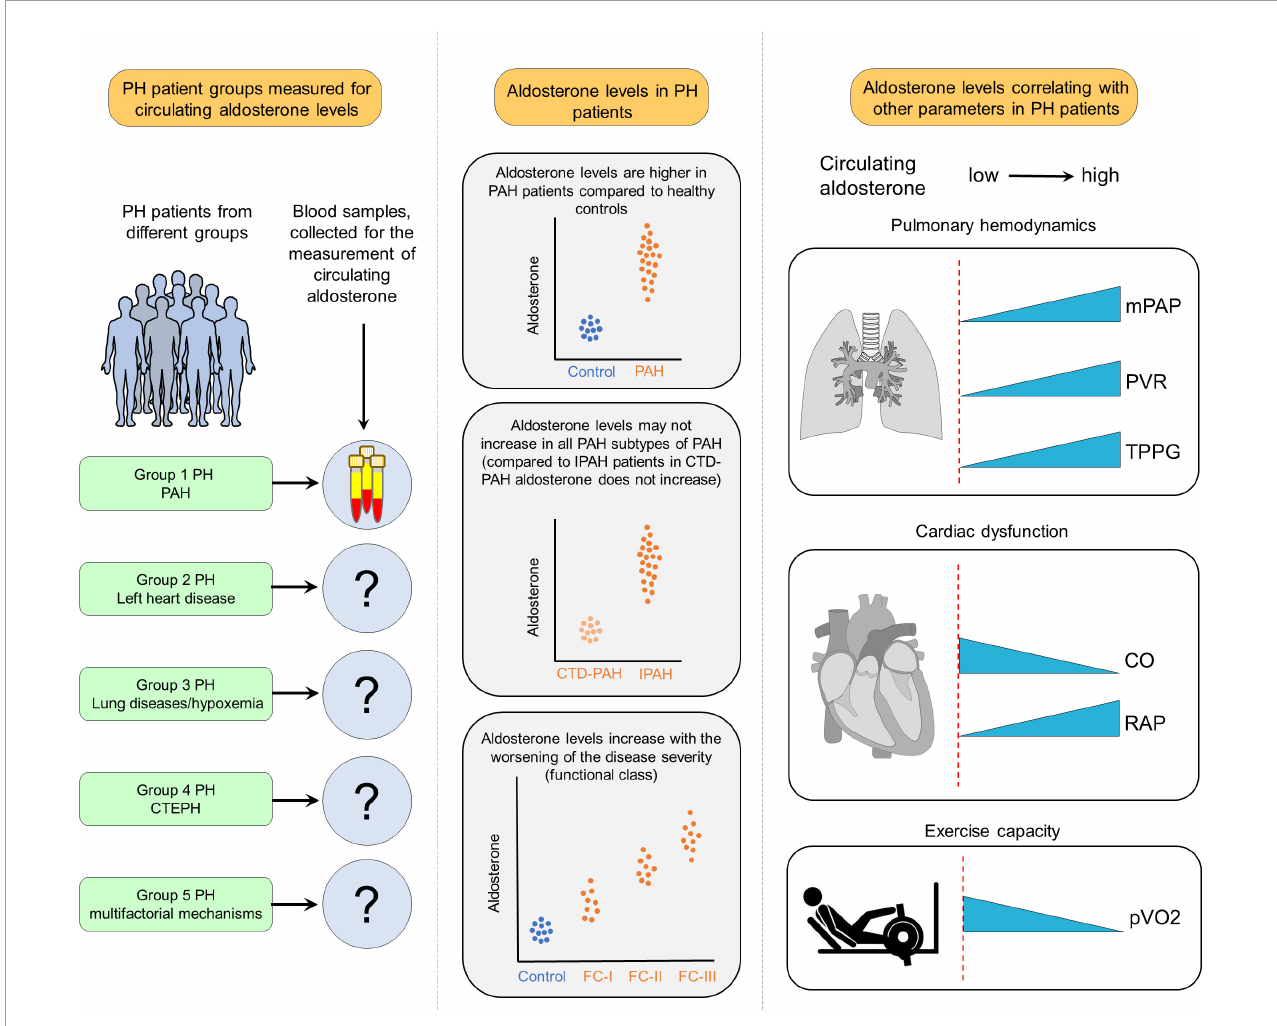
FIGURE1 Clinical implications of increased aldosterone levels in pulmonary hypertension (PH). In available studies, aldosterone levels have been measured mostly in Group 1 PH also referred to as pulmonary arterial hypertension (PAH), while in other forms of PH, circulating levels of aldosterone remained neglected. The results of those studies revealed that aldosterone levels are increased in PAH patients compared to healthy controls. In addition, there are differences in PAH subtypes regarding aldosterone levels. For example, compared to idiopathic PAH (IPAH), circulating aldosterone levels are not increased in PAH patients due to connective tissue diseases (CTD-PAH). Moreover, in PAH patients, aldosterone levels are increased along with worsening the disease severity. Furthermore, aldosterone levels are correlated with several hemodynamic and functional parameters like mean PA pressure (mPAP), pulmonary vascular resistance (PVR), transpulmonary pressure gradient (TPPG), cardiac output (CO), right atrial pressure (RAP), and decreased maximal oxygen uptake